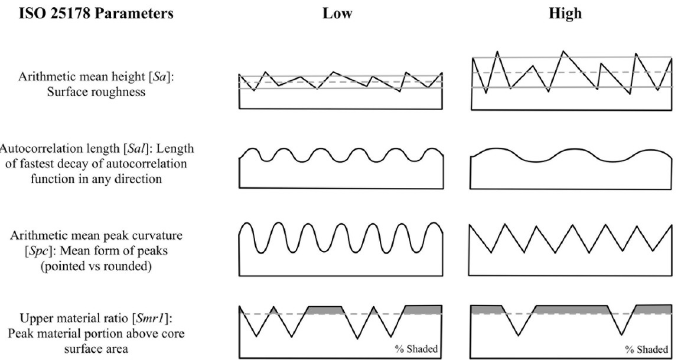
Fig 5. Visual representation of the surface parameters. (from Martisius et al., 2018 [49] (doi: https://doi.org/10.1371/ journal.pone.0206078.g004).